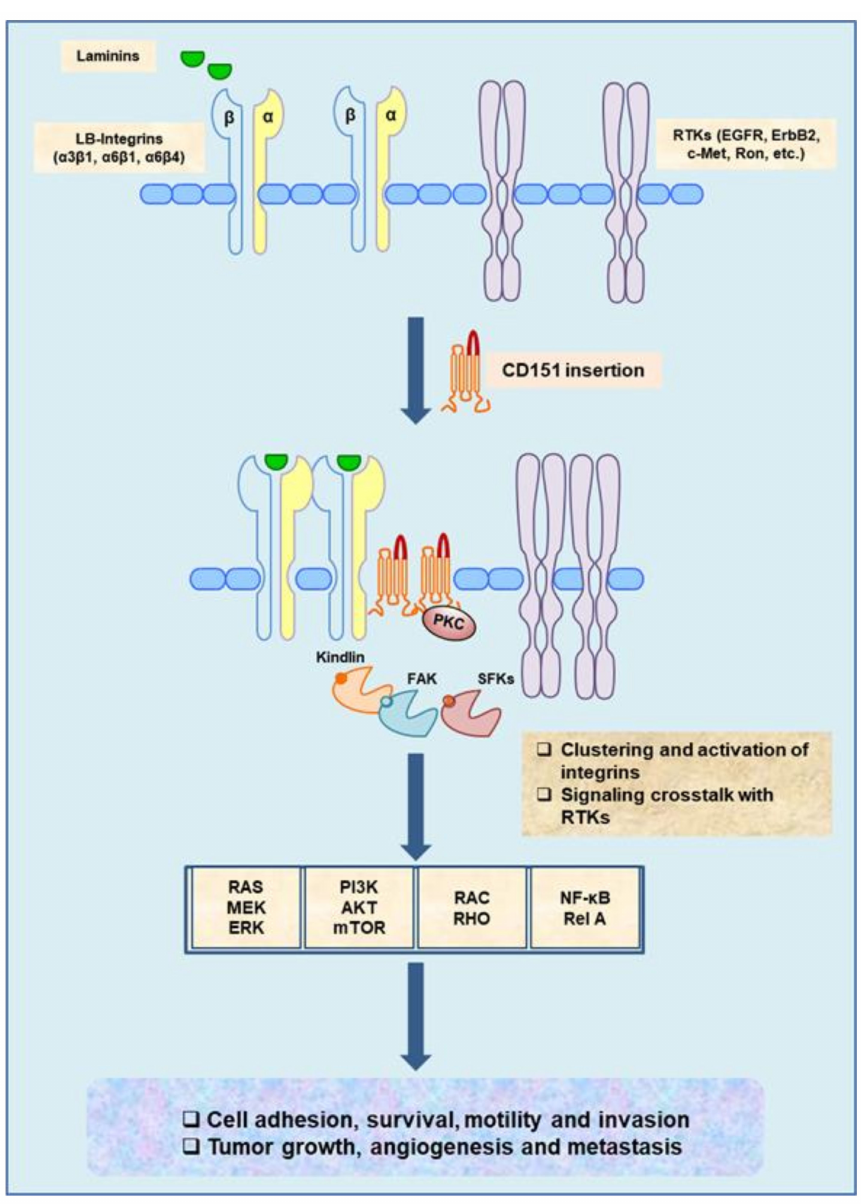
Figure 1. The pro-metastatic function and signaling pathways driven by CD151/laminin-binding (LB) integrin complexes and their crosstalk with oncogenic receptor tyrosine kinases (RTKs) in cancer cells and endothelial cells. The role of CD151 illustrated in a gain-of-function manner is based on observations from a series of studies with gene-targeted or shRNA knockdown effect in mouse models or cancer cell